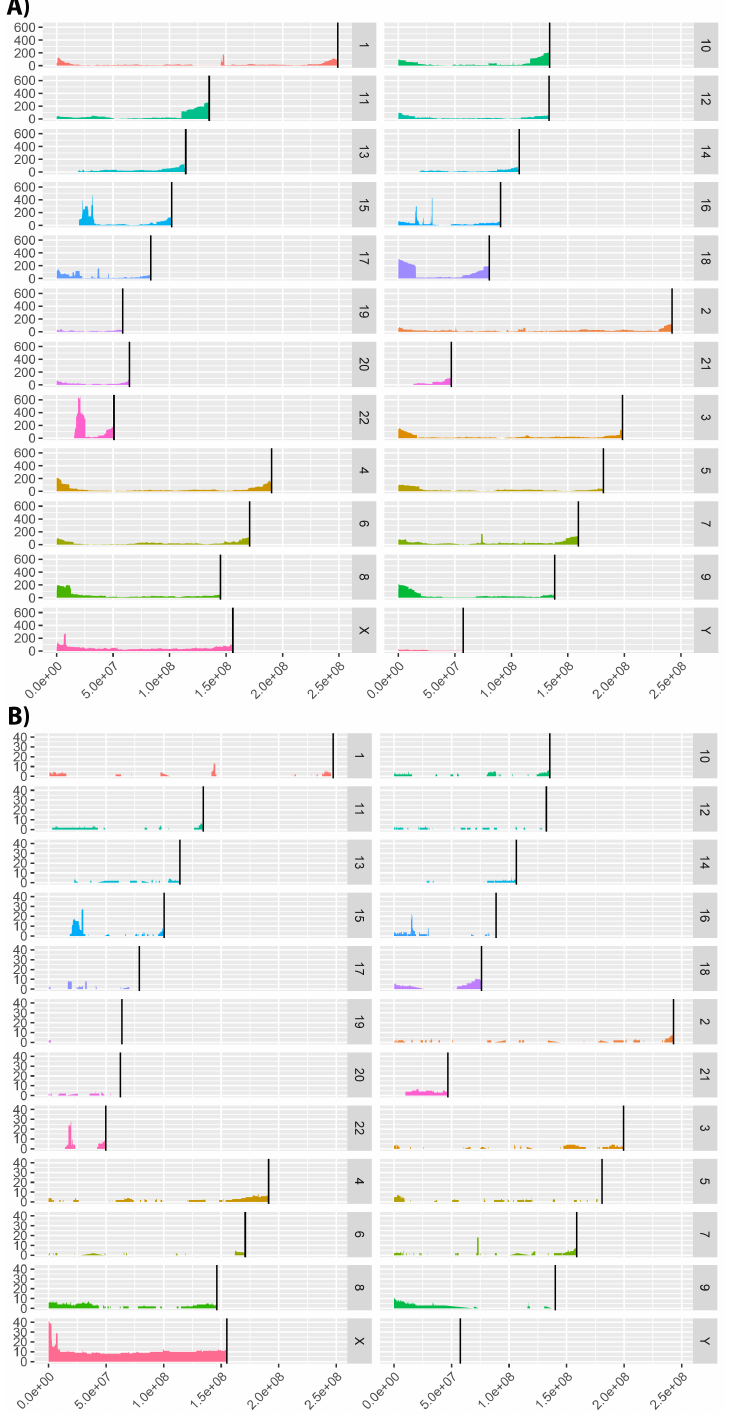
Figure 7. Genome coverage distribution for ( A ) DECIPHER (GRCh38/hg38 human genome assem- bly) and ( B ) ID/MCA (NCBI36/hg18 human genome assembly). Black vertical bars represent the end coordinate for each